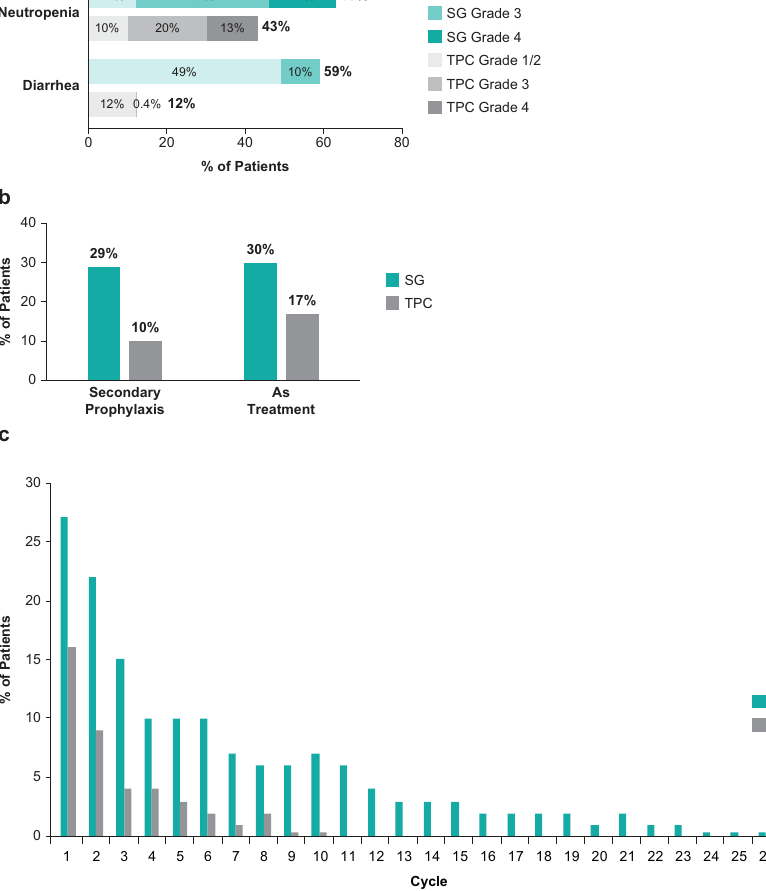
Fig. 2 Incidence of neutropenia and diarrhea, and G-CSF use. a Incidence of neutropenia and diarrhea by grade, b use of G-CSF in the safety population, and c use of G-CSF by cycle in the safety population. Percent of patients using G-CSF by treatment cycle is based on the total number of patients treated in cycle 1 (SG, n = 258; TPC, n = 224). G-CSF granulocyte colony-stimulating factor, SG sacituzumab govitecan, TPC treatment of physician ’ s